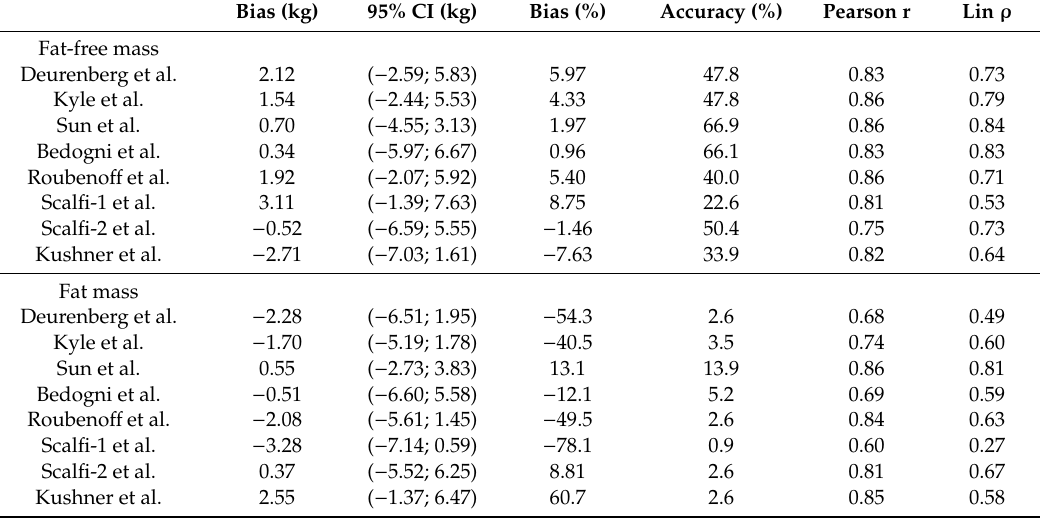
Figure 1. Comparison of fat-free mass (FFM) and fat mass (FM) measured by dual-energy X-ray absorptiometry (DXA) and bioelectrical impedance analysis (BIA) according to BIA equations. FFM (Upper panel) and FM (lower panel) values from 115 severely anorectic patients were compared with a Bland–Altman test. Bias (DXA-BIA values) and 95% confidence intervals (95% CI) are shown in blue and gray, respectively. Pearson correlations were performed and Pearson r is shown in red circles. The concordance coefficient of Lin ρ was calculated and is shown in green triangles. The green dashed line represents the cut-off at 0.81 to consider ρ fairly good. Table 5. Comparison of fat mass and fat-free mass values obtained by DXA and BIA according to the Table 3. Demographic data of patients. BIA equation